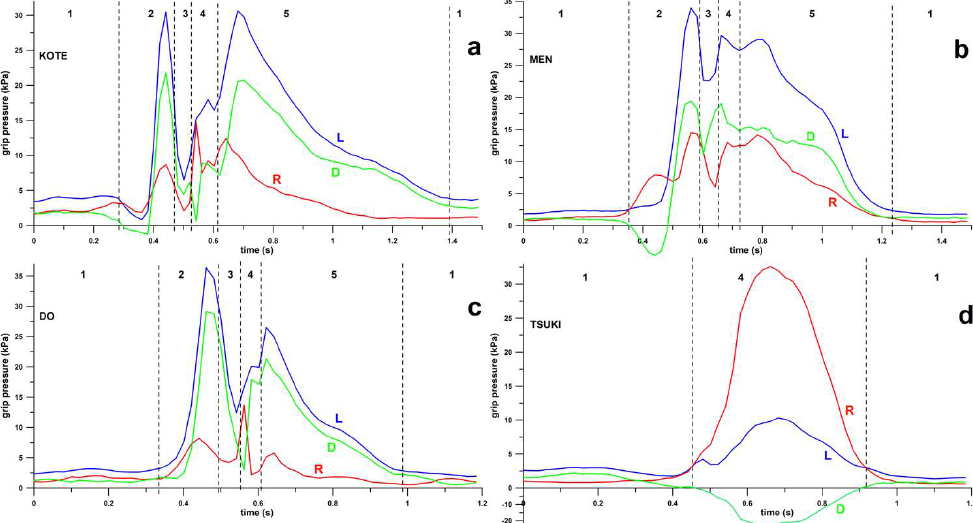
Figure 4. Example of grip pressure profile (pressure vs. time) of a participant hitting four different targets ( a ) Kote-bu, ( b ) Men-bu, ( c ) Do-bu, and ( d ) Tsuki-bu measured by the Smart Shinai; L = left hand, R = right hand, D = pressure differential (L–R); 1–5: attack phases; 1 = Kamae, 2 = Seme, 3 = Toraeru, 4 = Datotsu, 5 = Zanshin.